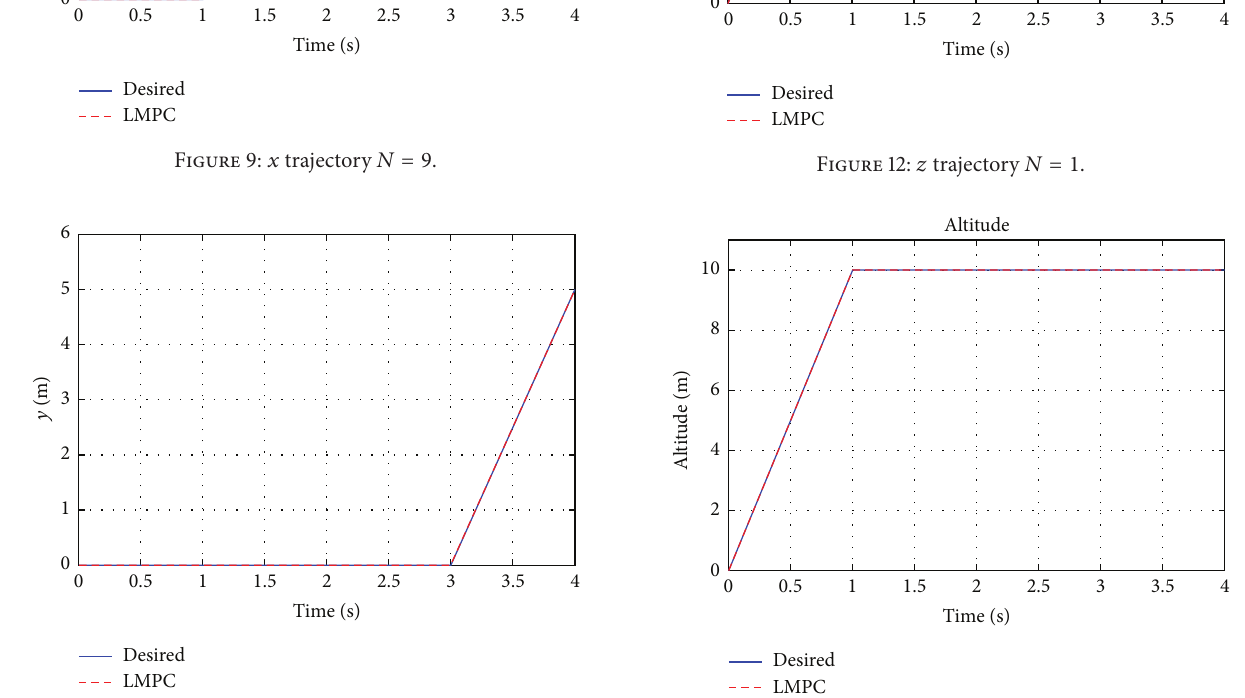
Figure 10: 𝑦 trajectory 𝑁 = 1 .